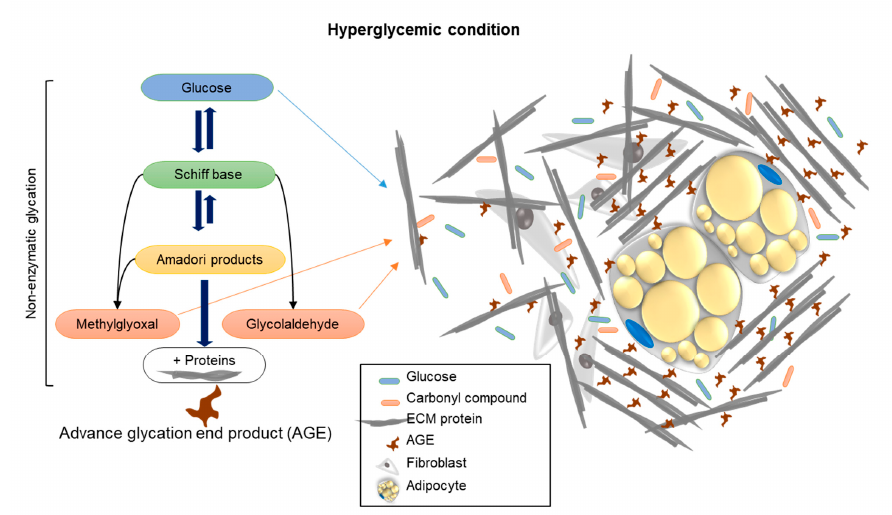
Figure 6. A schematic illustration showing the mechanism of how carbonyl compound-induced hyperglycemia affects the cell’s niche stiffness through the formation of AGEs leading to changes in protein structure and functionality.